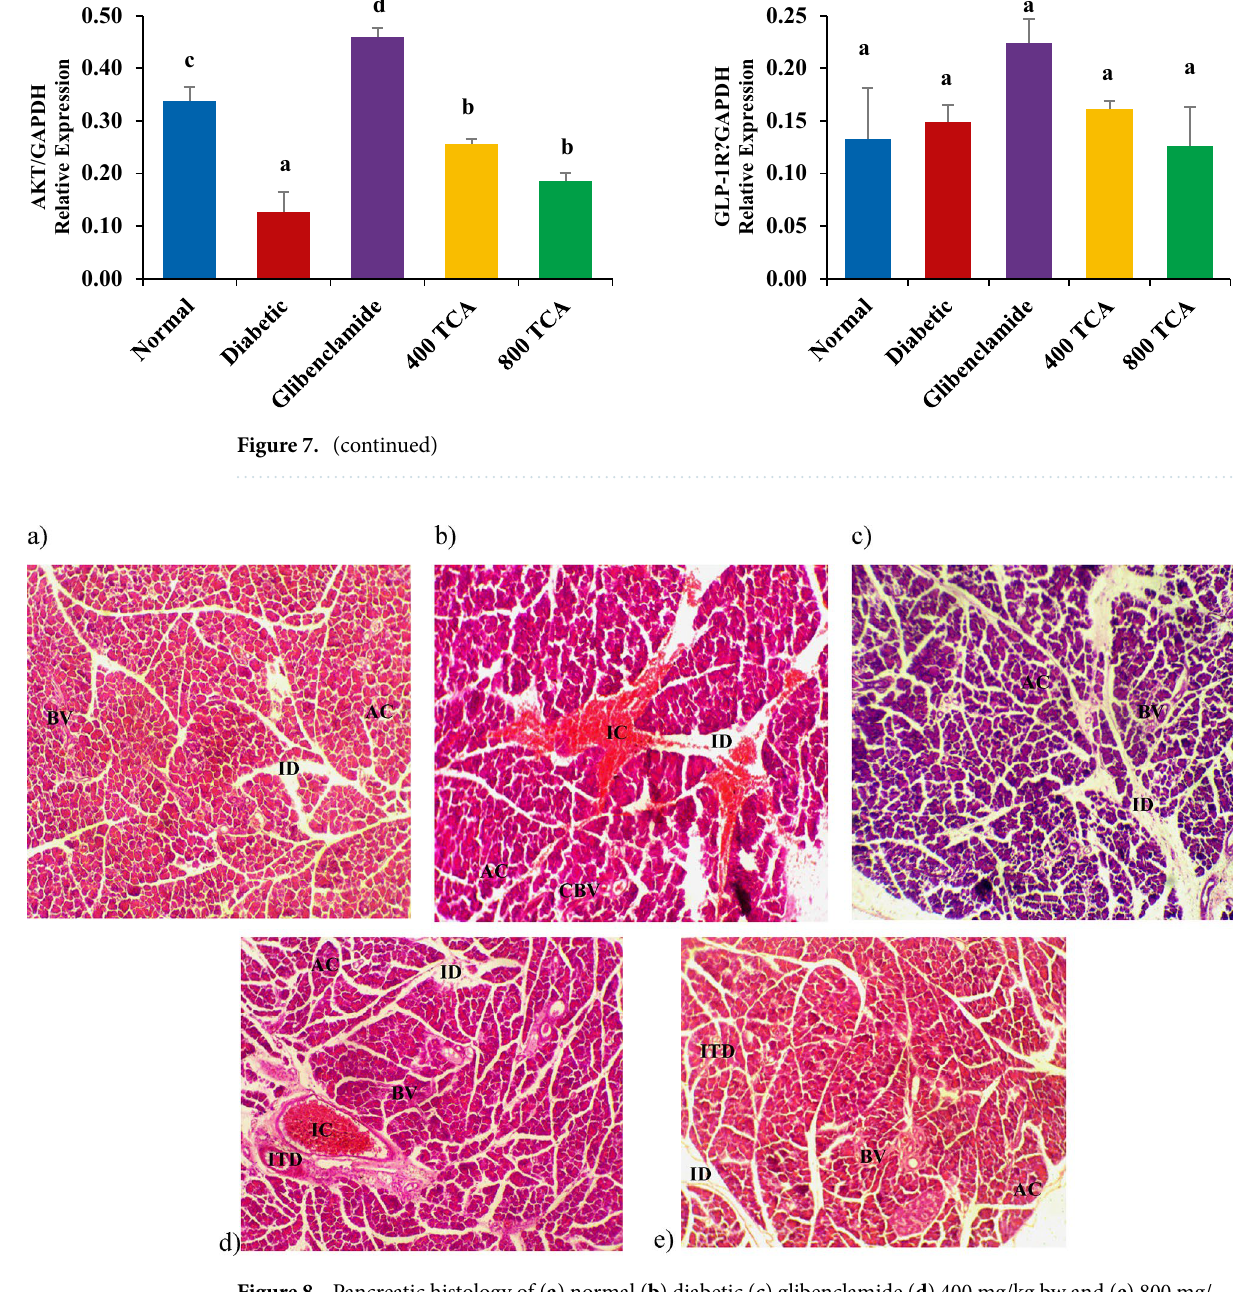
Figure 8. Pancreatic histology of ( a ) normal ( b ) diabetic ( c ) glibenclamide ( d ) 400 mg/kg bw and ( e ) 800 mg/ kg bw T. catappa aqueous extract treatment of HFD/STZ-induced diabetic rats (H&E × 100). ID: intralobular duct, BV: blood vessel, AC: acini, IC: inflammatory cell, CBV: congested blood vessel, ITD: interlobular